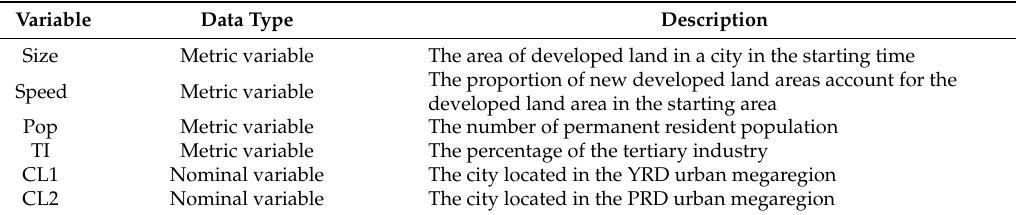
Table 1. Description of the predictor variables used in the statistical